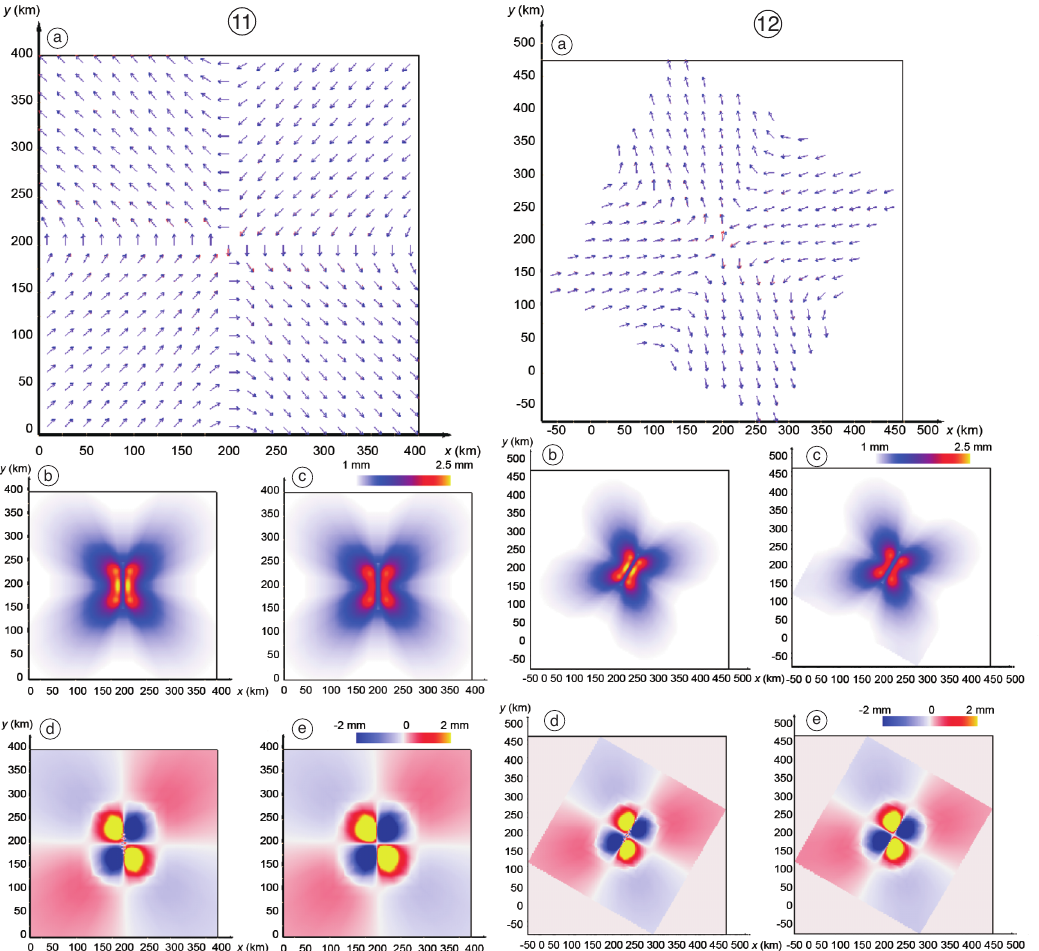
Fig. 11a-e. Ground displacement field for a right-lateral strike slip with δ = 90° and φ = 0° when the Okada dis- placements are applied as inhomogeneous boundary conditions. Horizontal displacement field (on the left ): a) nu- merical and analytical results are displayed simultaneously as a vector plot (blue arrows: numerical solution; red arrows: analytical solution); b) numerical and c) analytical solutions are displayed as color plots. Vertical displace- ment field (on the right ): d) numerical and e) analytical solutions are displayed as color plots. Fig. 12a-e. Same as fig. 11a-e but for a right-lateral strike slip with δ = 90° and φ =